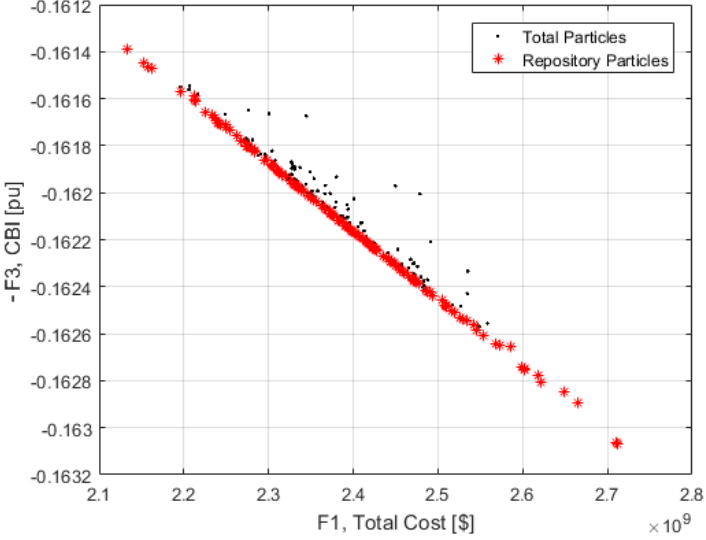
Figure 8. Pareto optimality (Scenario 2).